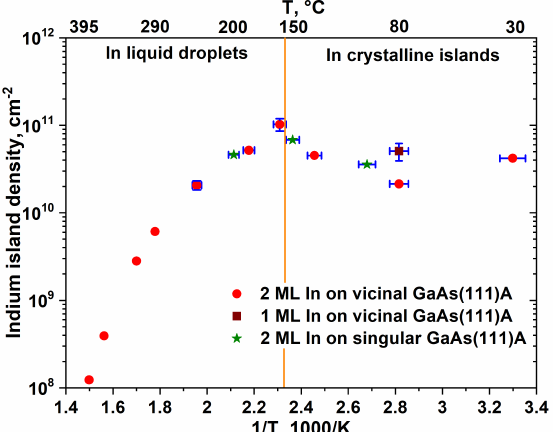
Figure 2. Temperature density dependence of self-assembled indium islands. Red circles correspond to 2 ML In deposited on vicinal GaAs(111)A with 2 ◦ miscut towards ( 112 ) ; the brown square corresponds to 1 ML In deposited on vicinal GaAs(111)A with 2 ◦ miscut towards ( 112 ) at 80 ◦ C; and green stars correspond to 2 ML In deposited on singular GaAs(111)A at 100, 150, and 200 ◦ C. Temperature error is ± 5 ◦ C. The temperature or density error bar is not presented if it is less than the size of red circles or green stars. Orange line indicates the indium melting point ( T melt = 156.6 ◦ C). In Data in Figure 2 were conveniently analyzed by considering separately liquid and solid